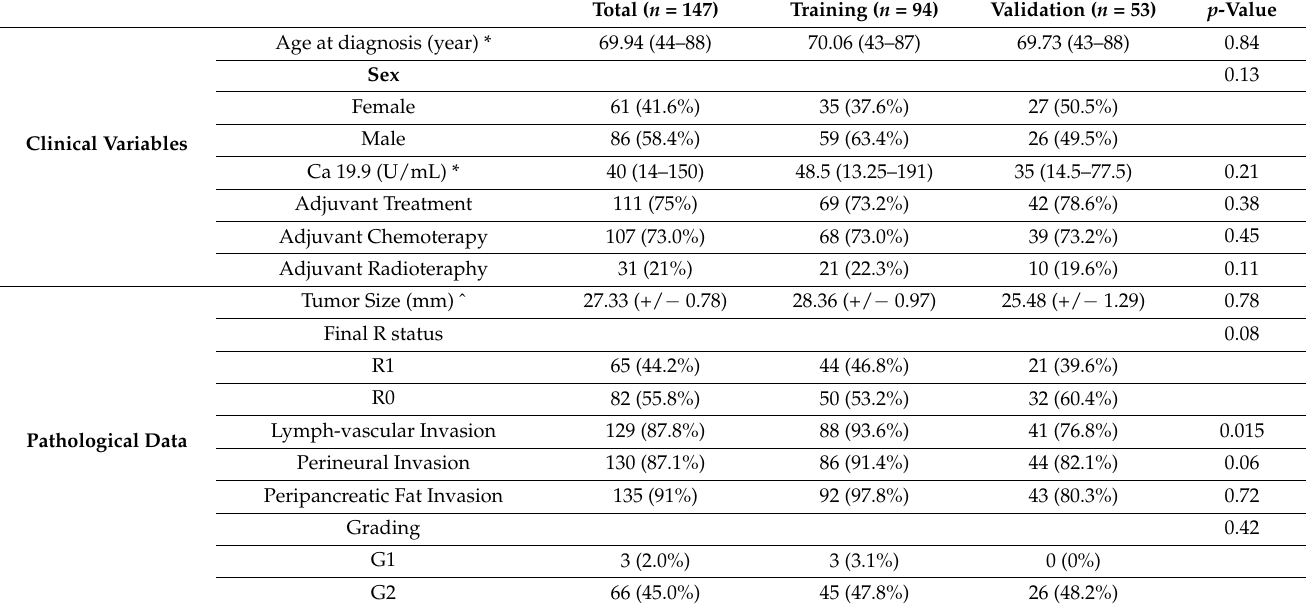
Table 1. Clinical, pathological and radiological patients’ data and outcome